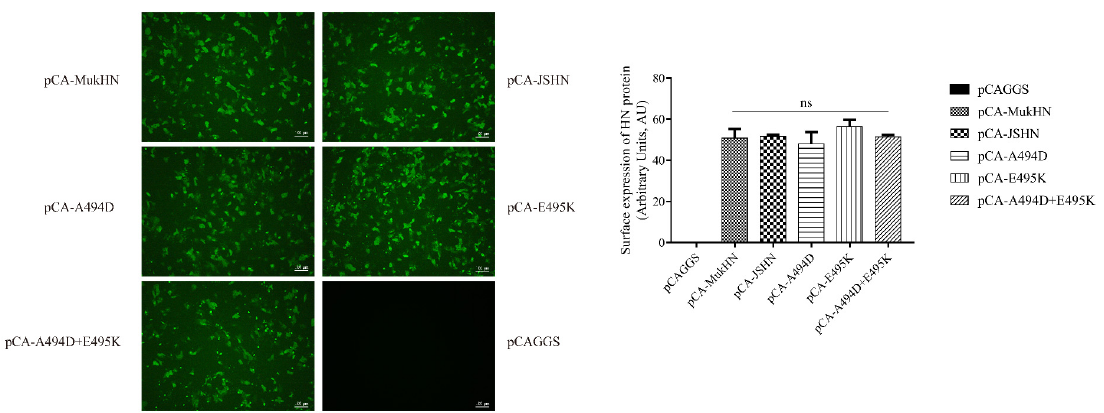
Figure 3. Analysis of expression efficiency of different HN proteins. Different HN protein expression plasmids were transfected into Vero cells, followed by incubating with the HN protein primary antibody and corresponding secondary antibody. Images were then taken by a fluorescent microscope at × 100 magnification. Bar indicates 100 µ m. IFA results were evaluated by the ImageJ software. ns indicates no